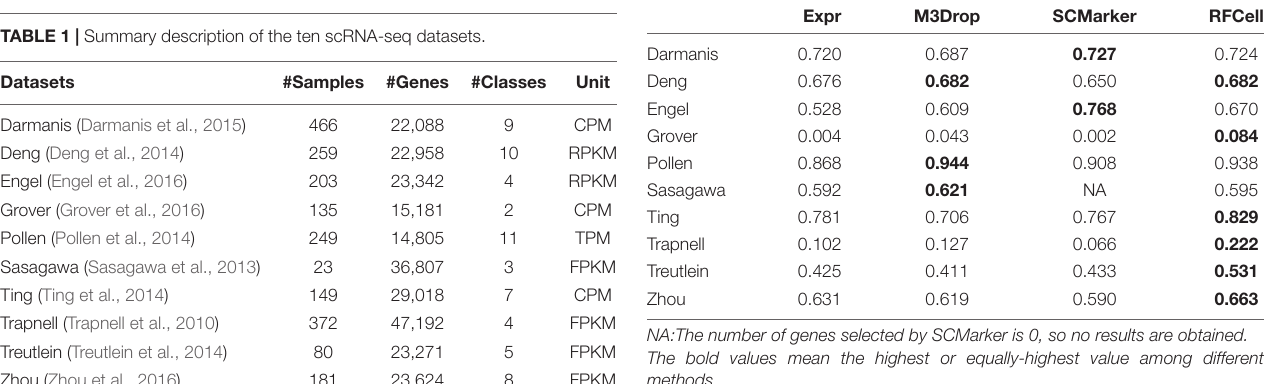
TABLE 2 | Comparison of SIMLR performance of gene sets obtained by four gene selection methods in terms of NMI.